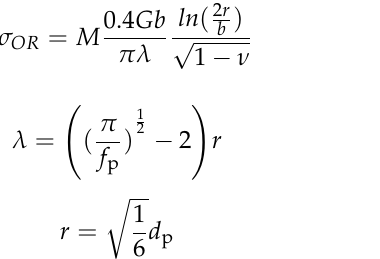
Figure 15. TEM bright-field image and HRTEM image of ZL205A alloy with 0.3%Al–5Ti–0.8C + 0.1%La: ( a ) the interface of Al and TiC, ( b ) θ’(Al 2 Cu)-dependent TiC precipitation, ( c ) PFZ (Precipi-